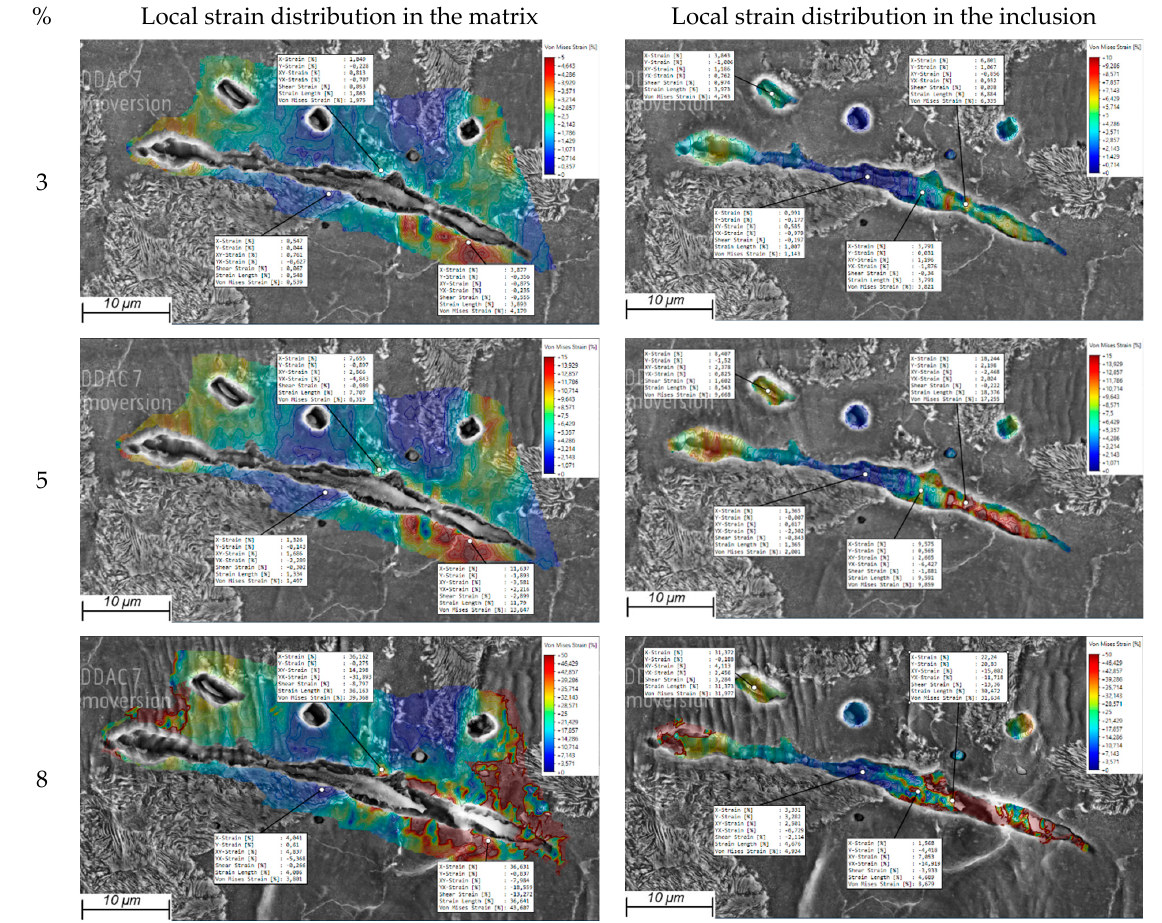
Figure 12. Local strain distribution in ferrite matrix and MnS inclusion at 3%, 5.5%, and 8% global strains.